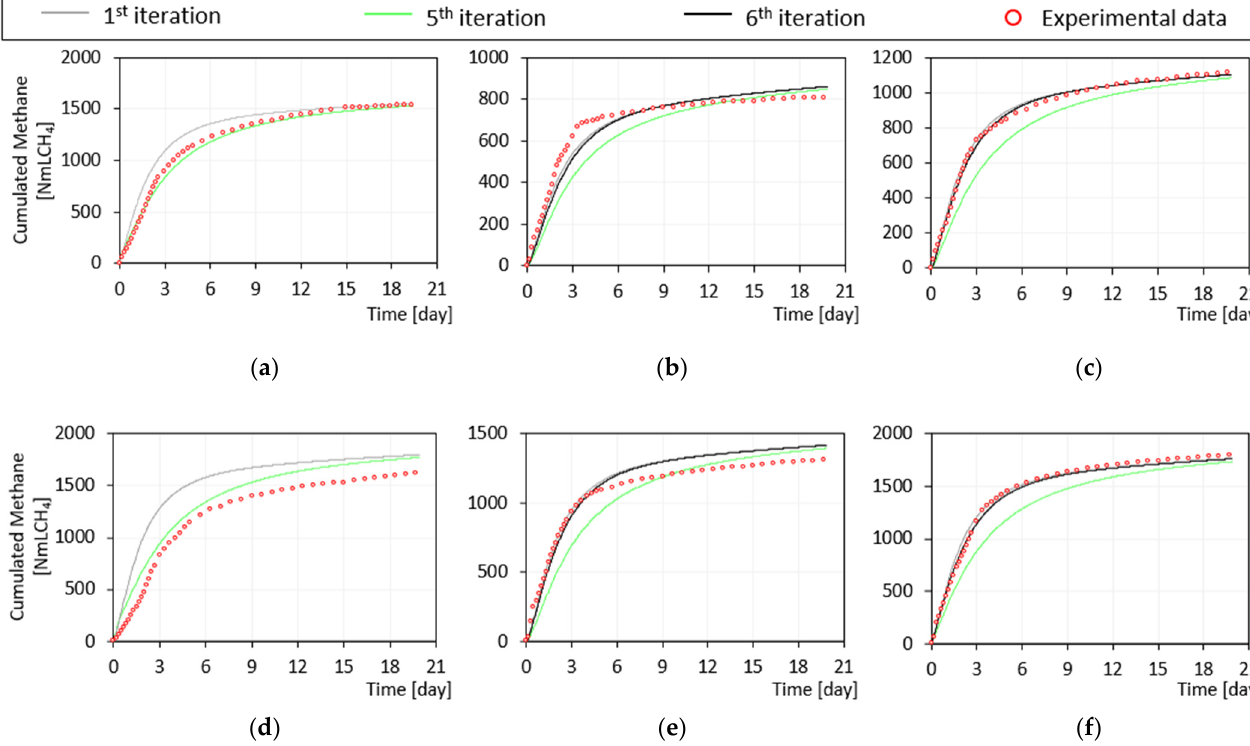
Figure 5. Experimental vs. simulated cumulated CH 4 volume in BMP tests on ( a ) sludge—Phase I, ( b ) yogurt—Phase I, and ( c ) co-digestion—Phase I, ( d ) sludge—Phase II, ( e ) yogurt—Phase II, and ( f ) co-digestion—Phase II. The y-axis shows the gross volume of methane produced (NmLCH 4 ).